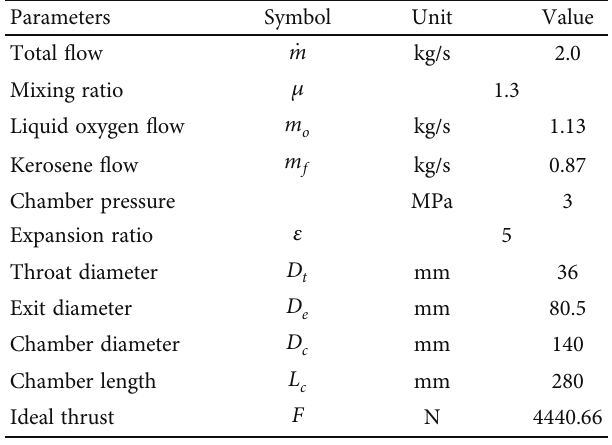
Table 3: Design parameters of the thrust chamber.